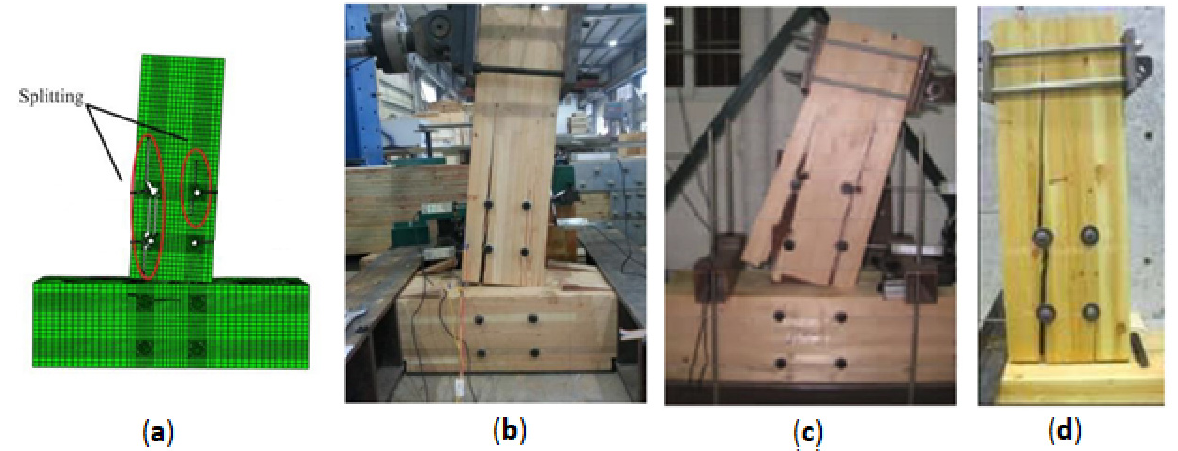
Figure 11. Comparison of the failure modes (adapted from [33]): ( a ) finite element model, ( b ) specimen (adapted from [20]), ( c ) specimen (adapted from [31]), and ( d ) specimen, (adapted from [25]).